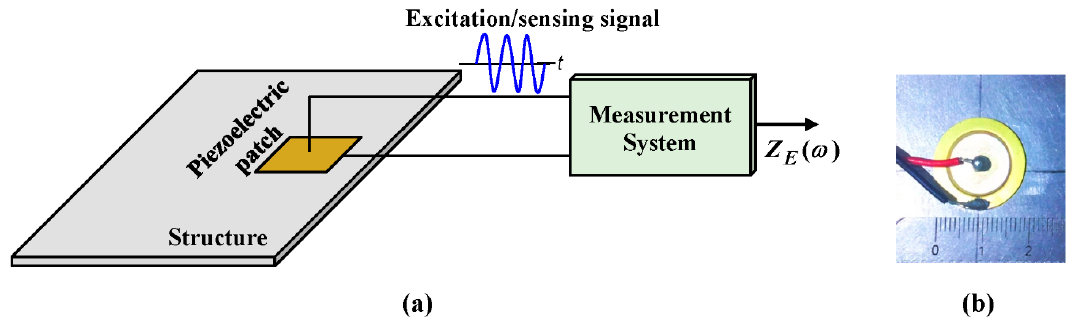
Figure 1. ( a ) Principle of the EMI method [11] and ( b ) piezoelectric transducer used in this